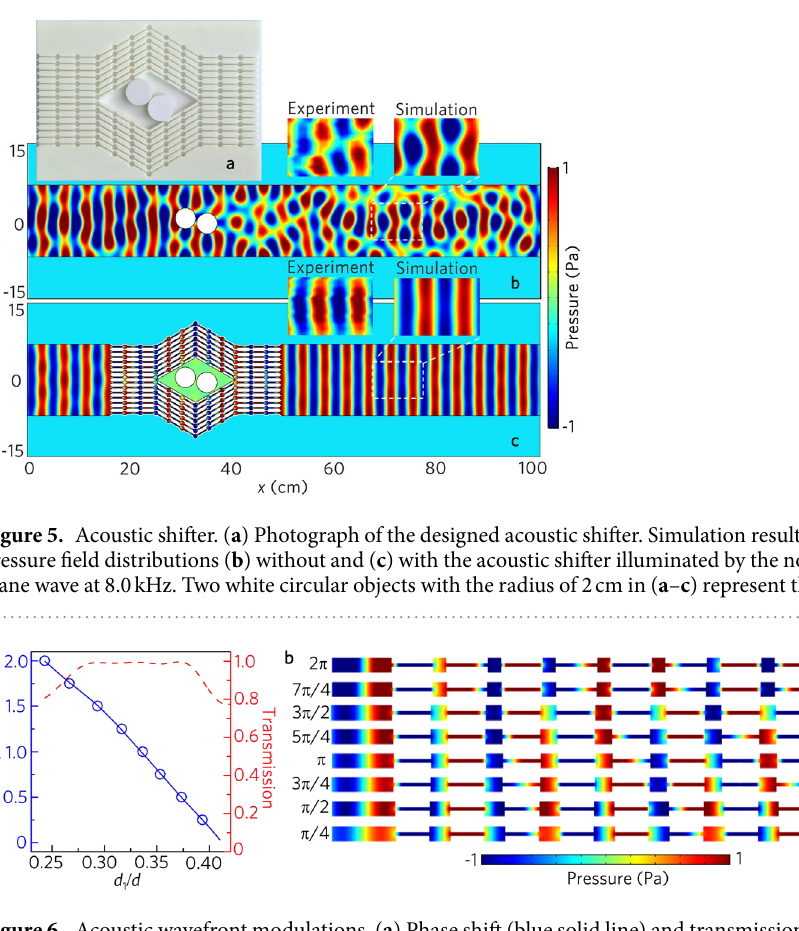
Figure 6. Acoustic wavefront modulations. ( a ) Phase shift (blue solid line) and transmission spectrum (red dashed line) of the acoustic metafiber as a function of the tunable cavity length ratio ( d 1 / d ). ( b ) Simulated acoustic pressure field distributions through eight different acoustic metafibers for an equally increased phase shift with a step of π /4, corresponding to eight hollow blue dots d 1 / d = 0.243, 0.267, 0.293, 0.317, 0.337, 0.353, 0.373 and 0.393 in ( a